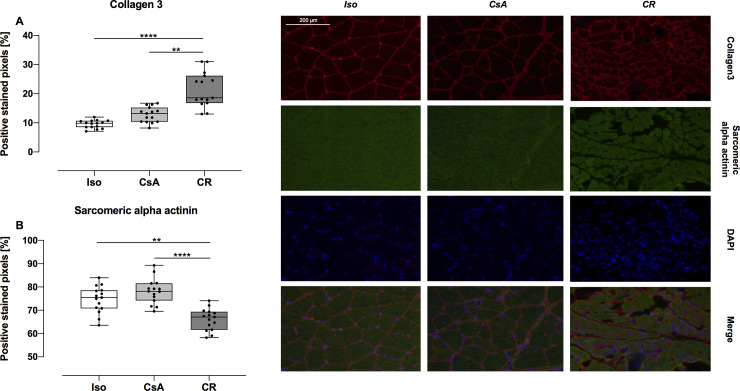
Amount of collagen3 (A) and sarcomeric alpha actinin (B) in muscle at POD 100. Data is presented as individual data points and boxplots; boxplots show the median, 25%- and 75%-quartile; whiskers indicate the minimum and maximum. CR muscle showed a significant increase in collagen 3, whereas sarcomeric alpha actinin is significantly decreased, compared to Iso and CsA muscle. Representative immunofluorescent images of Iso, CsA and CR muscle tissue (**: p < 0.01; ****: p < 0.0001).